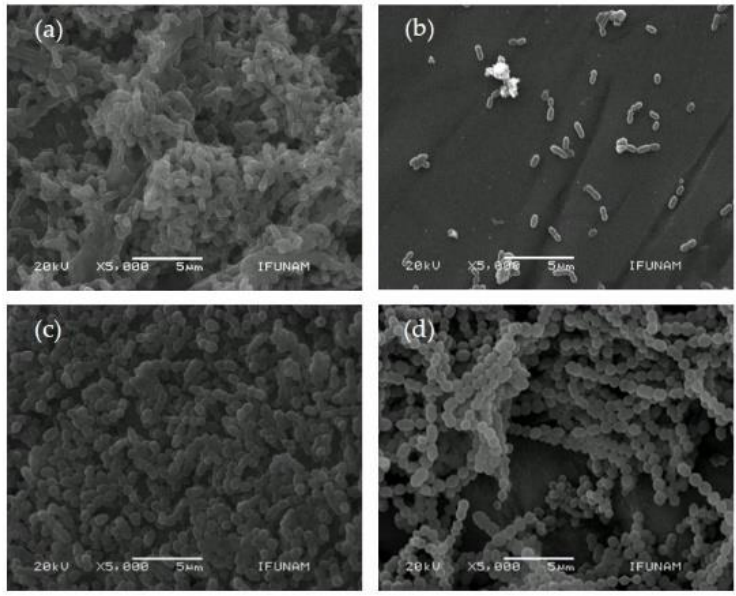
Figure 3. Representative scanning electronic microscopic (SEM) of dental enamel incubated with microorganisms; original magnification, 5000 × ; scale bar = 5 µ m; ( a ) deciduous enamel with S. mutans ; ( b ) permanent enamel with S. mutans ; ( c ) deciduous enamel with S. sanguinis ; ( d ) permanent enamel with S. sanguinis .